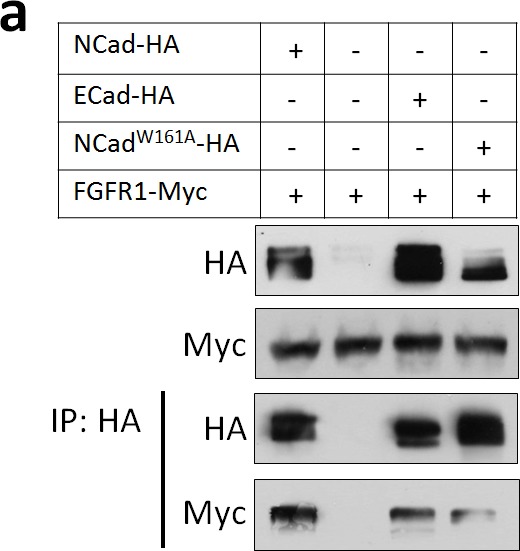
FGFR1 binds NCad, NCadW161A and ECad HEK293T cells were transfected with FGFR1-Myc and NCad-HA, vector, ECad-HA or NCadW161A-HA.24 hr later, cells were lysed and lysates and anti-HA immunoprecipitates analyzed by Western blot. To equalize FGFR1-Myc expression level, half the amount of FGFR1-Myc DNA was transfected with NCad-HA or NCadW161A-HA.